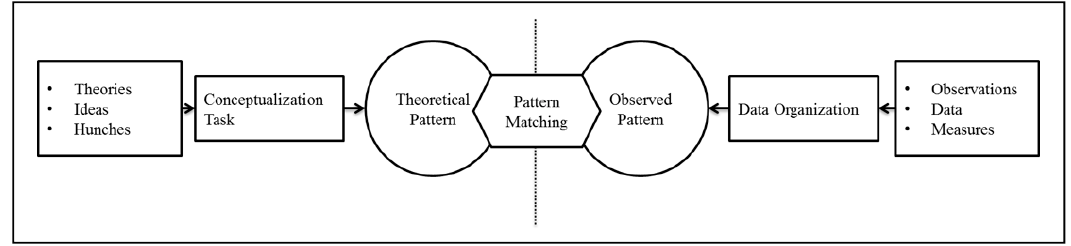
Figure 2. The pattern matching model. Source: Author’s Elaboration from Trochim [57]